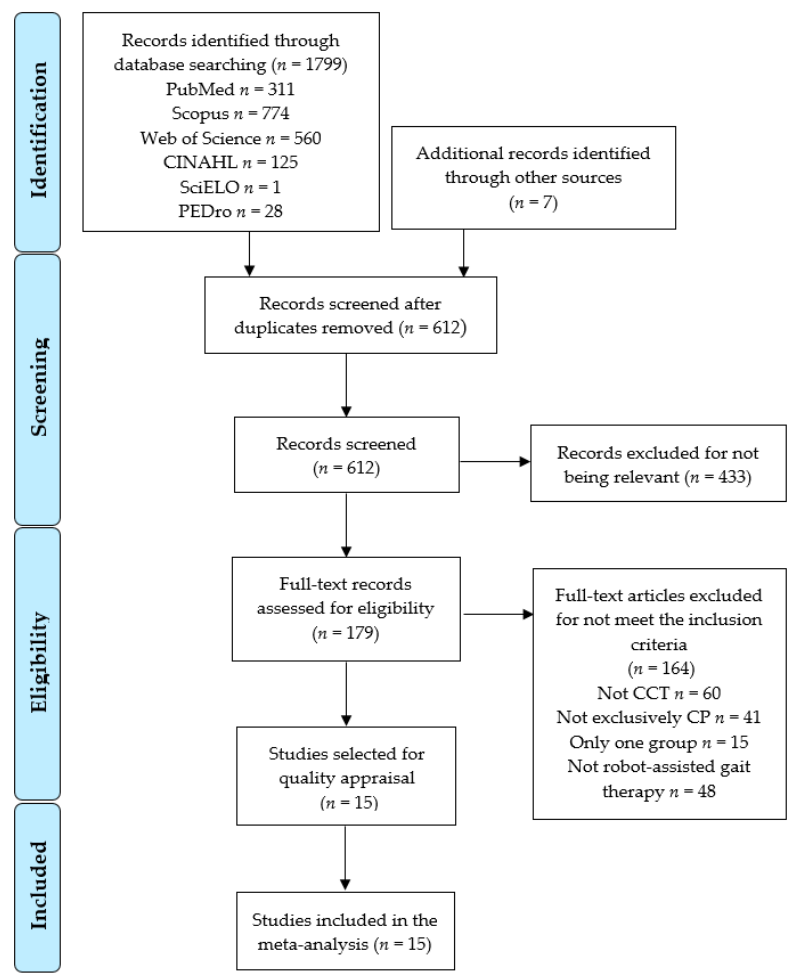
Figure 1. PRISMA Flow Diagram.